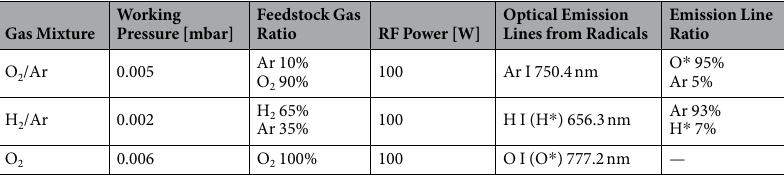
Table 1. Plasma parameters used for the different cleaning runs.